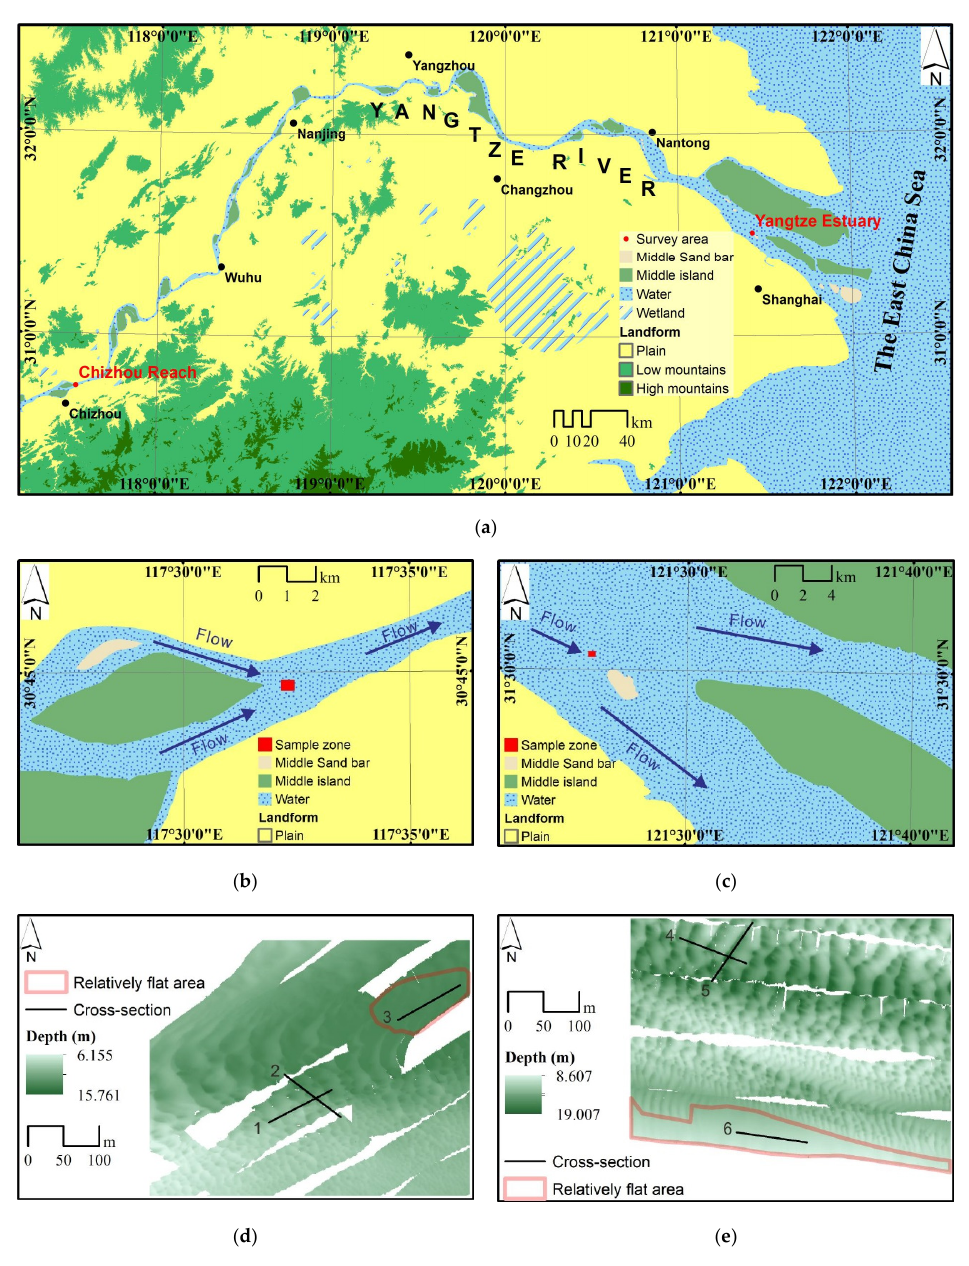
Figure 1. ( a ) Location of the two bathymetric survey areas in Yangtze River, ( b ) geomorphologic environment surrounding Chizhou Reach, and ( c ) that of the Yangtze Estuary. ( d ) Sample data for Chizhou Reach and ( e ) Yangtze Estuary. Six cross-sections were set in the sample zones and used to compare the water depth profiles with the distribution of mapped geomorphic